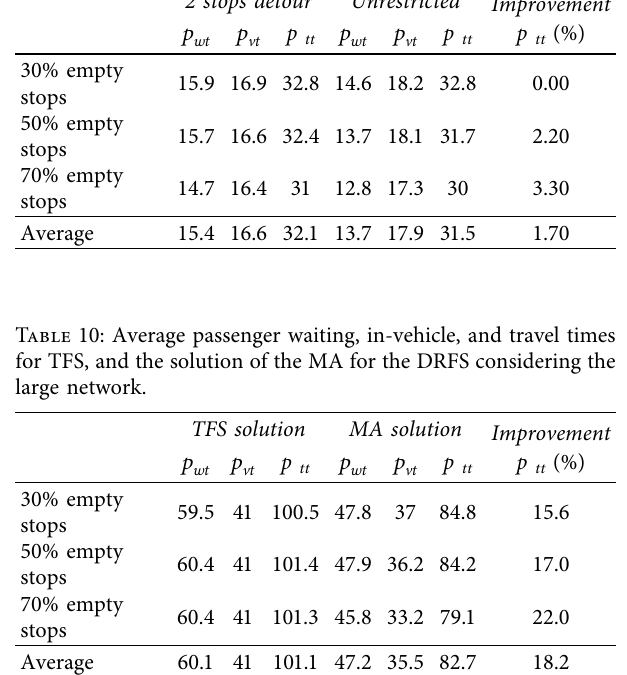
Table 9: Average passenger waiting, in-vehicle, and travel time for 60 instances comparing limited detour policy and unrestricted movements for the lines. 2 stops detour Unrestricted Improvement